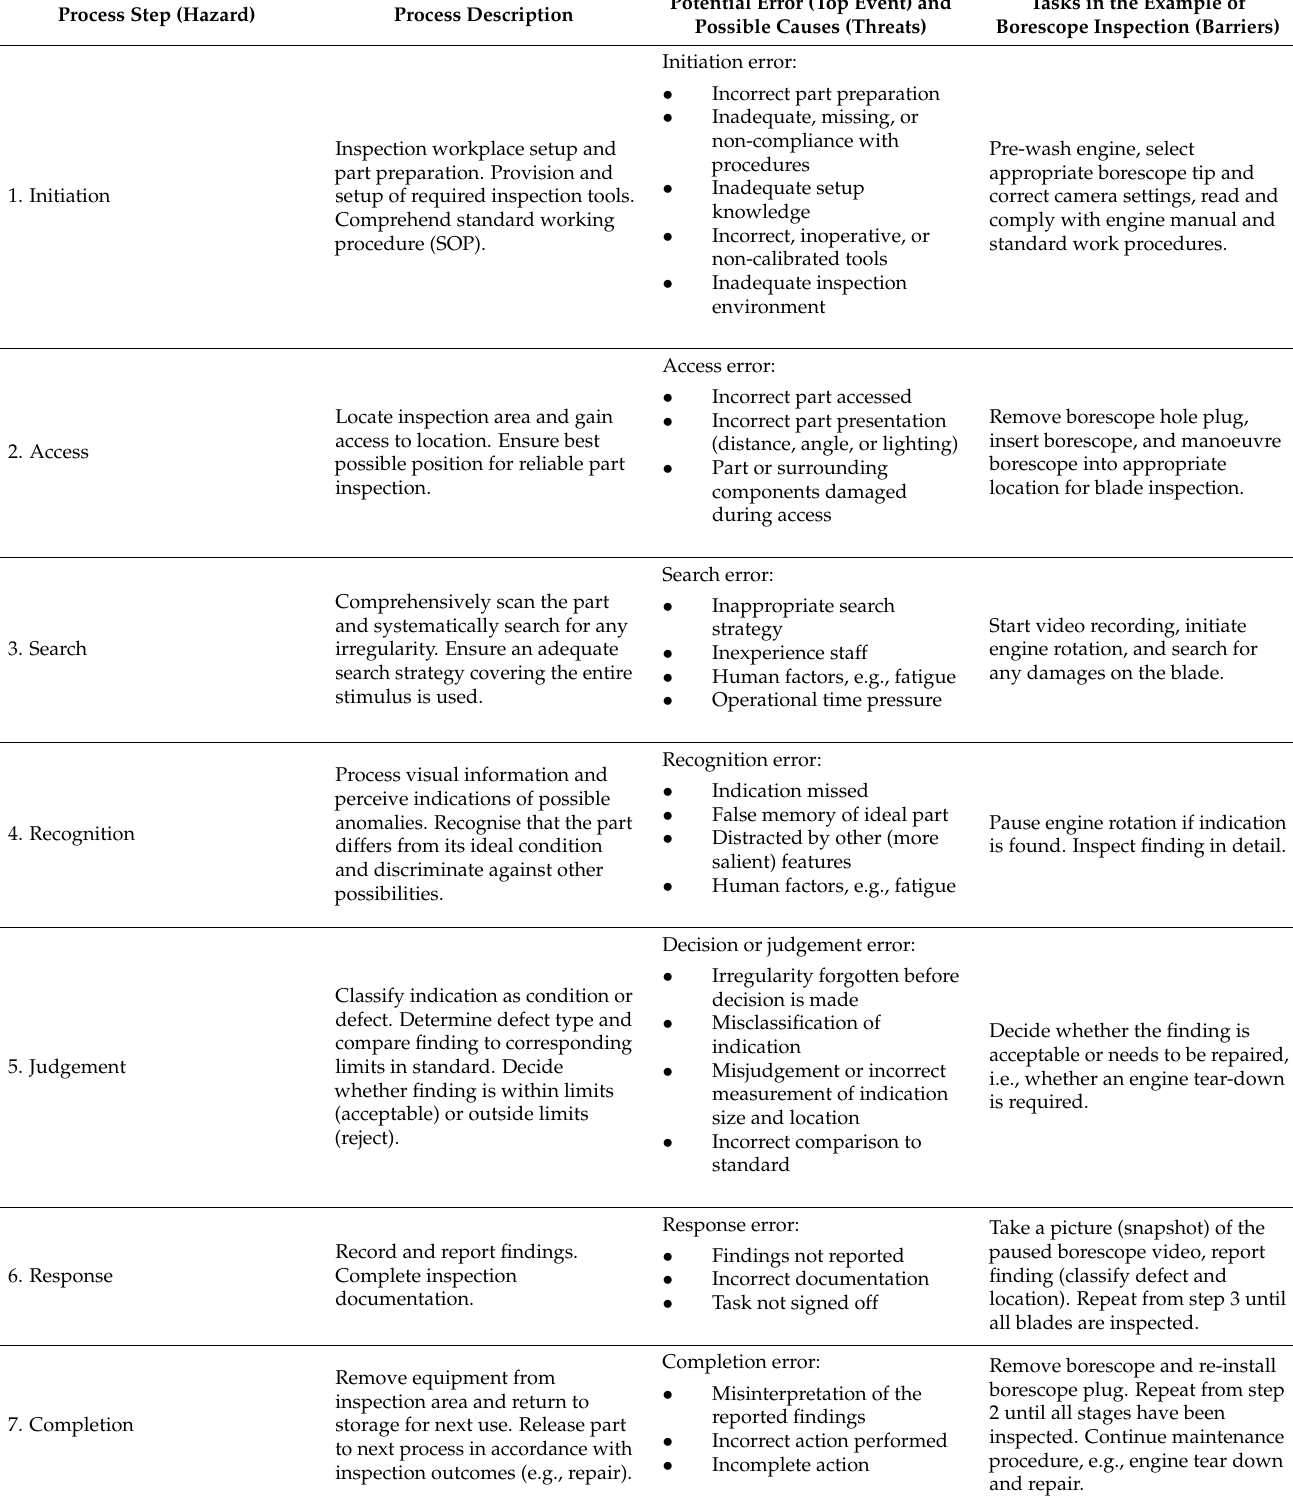
Table 9. Description of the Visual Inspection Framework exemplary for borescope